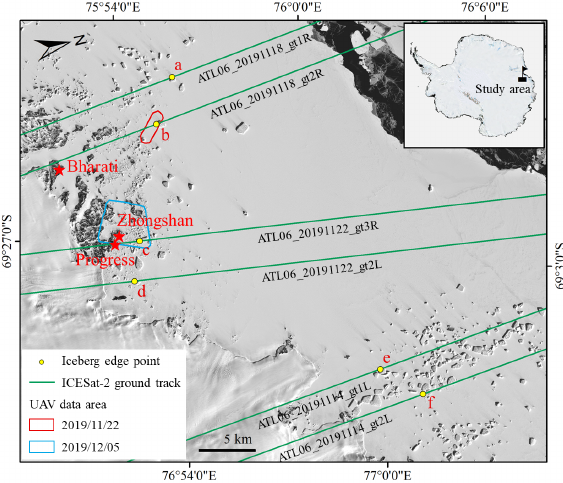
Figure 1 . Location of the study area (inset) and experiment data (UAV data and ICESat-2 ground track) overlaid on Sentinel-2 optical image captured on September 30, 2019.